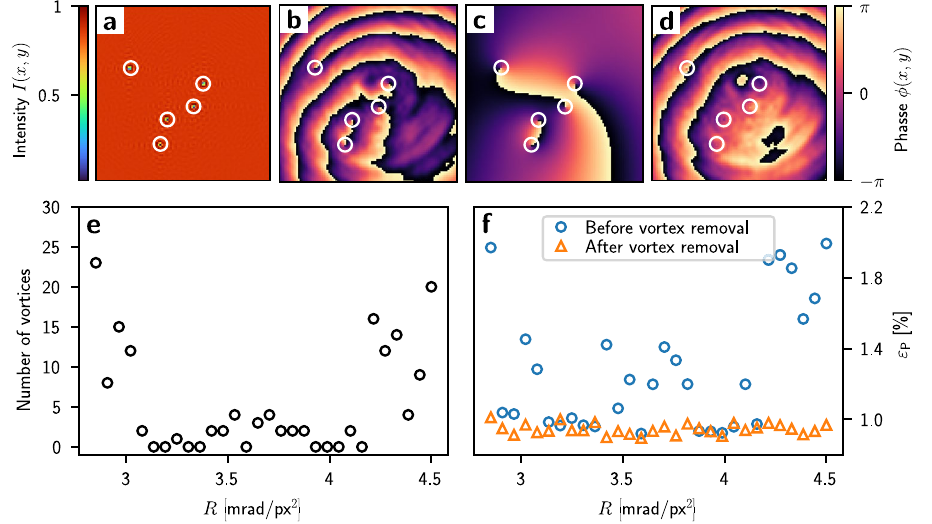
Figure 6. Detection and removal of optical vortices in the disc-shaped light potential. ( a ) Intensity of the light potential, showing the central 100 × 100 pixels; ( b ) phase, φ , of the same potential, ( c ) phase, φ v of the vortices only, ( d ) phase, φ − φ v , of the corrected field with vortices removed. ( e ) Number of vortices detected in the light potential after 100 CG iterations and 10 feedback iterations, using different values for the quadratic curvature, R , in the initial phase guess. ( f ) Predicted RMS error, ε P , before vortex removal (blue circles) and after (orange